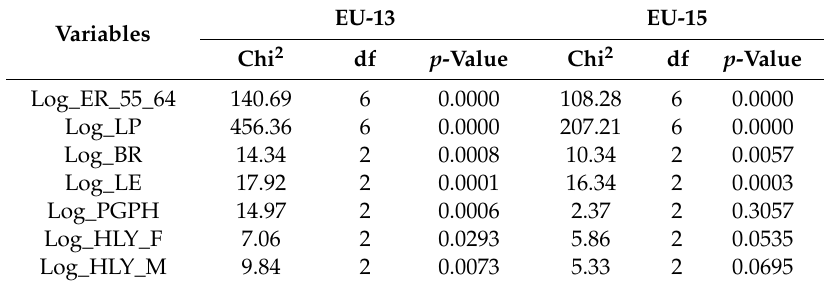
Table A4. Wald tests for equations associated with the SEM models, EU-13 and EU-15, 1995–2017.